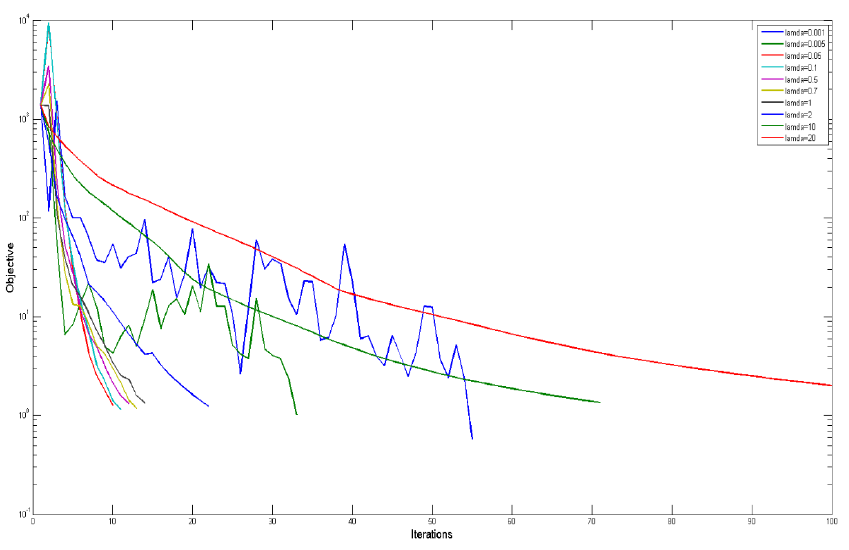
Figure 13—Objective function behavior with iterations for different